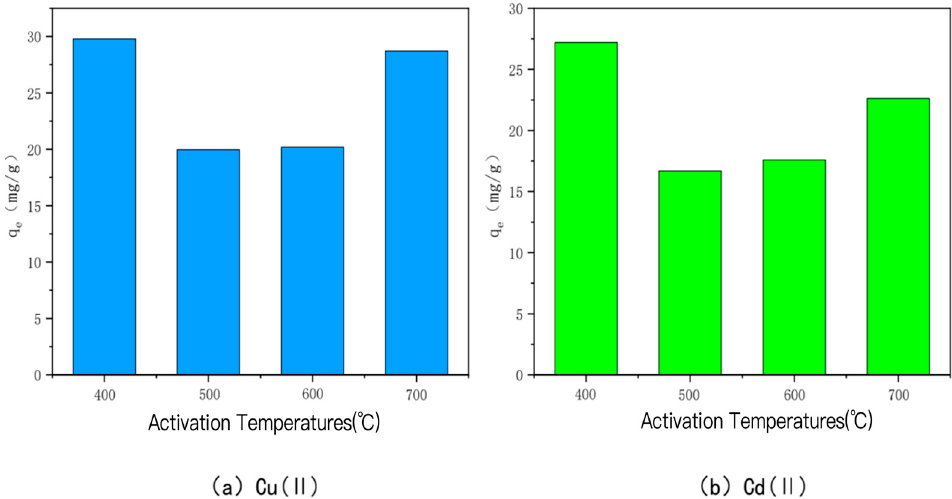
Figure 4. The adsorption capacity of Cu(II)/Cd(II) adsorbed by KOH-activated modified carbon at different activation